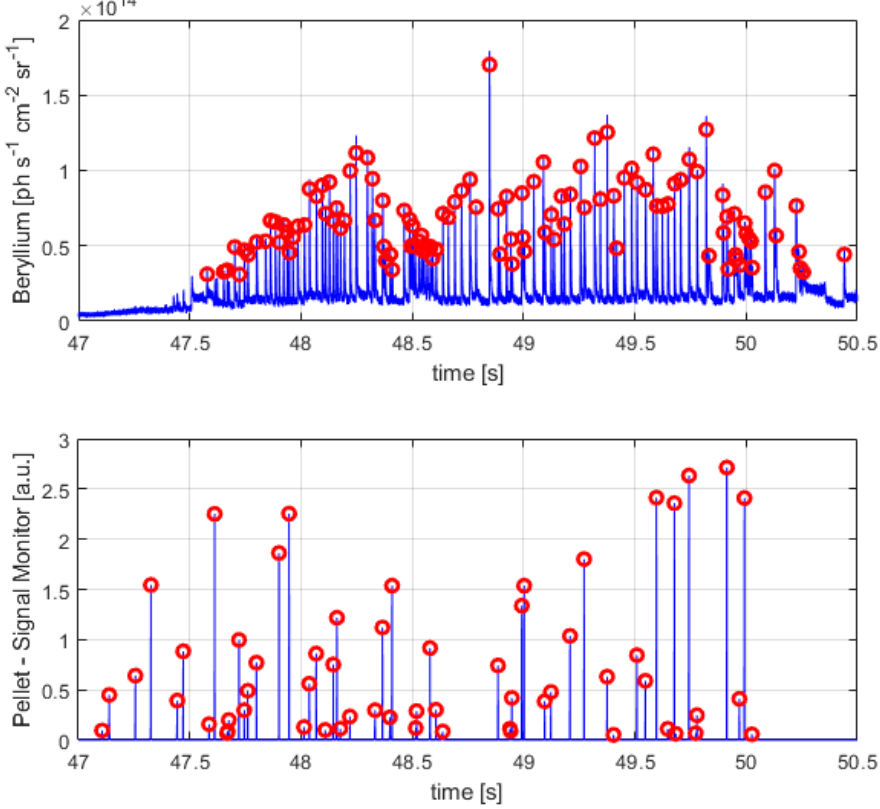
Figure 6. Pulse 92238. ELM signals with detected ELMs ( top ) and pellet monitor signals with detected Pellets ( bottom ) using the peak detection algorithm.